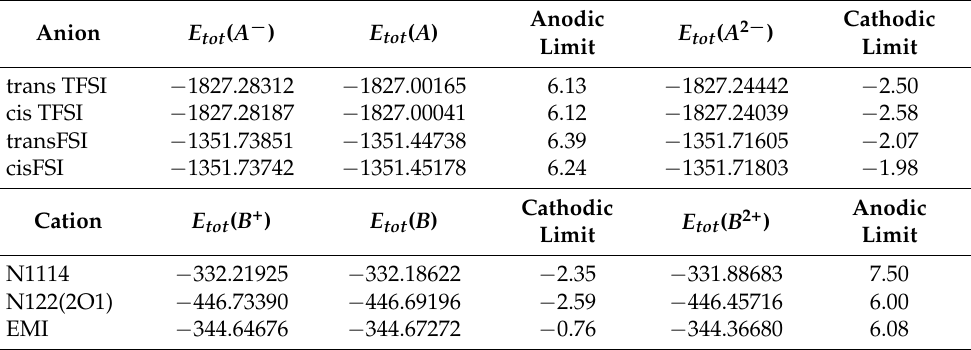
Table 3. Electronic energy (in atomic units) of anions and cations and their unrelaxed neutral or double charged forms calculated at the B3LYP/6-31G** level of theory in a polar medium and derived anodic and cathodic limit